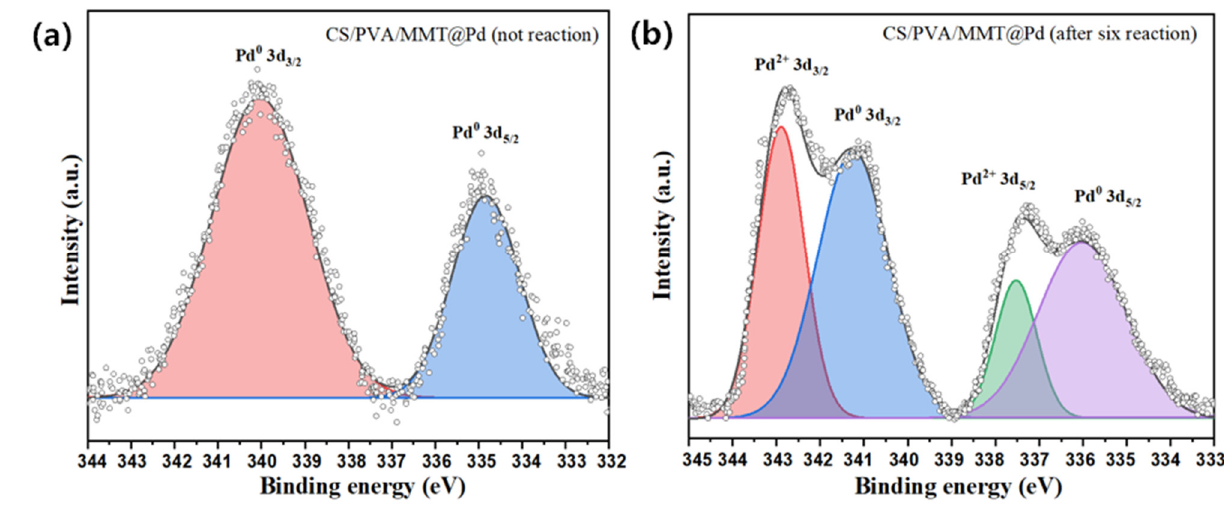
Figure 8. ( a ) XPS analysis of elemental Pd on CS/PVA/MMT@Pd (no reaction) and ( b ) CS/PVA/MMT @Pd (after six reactions).